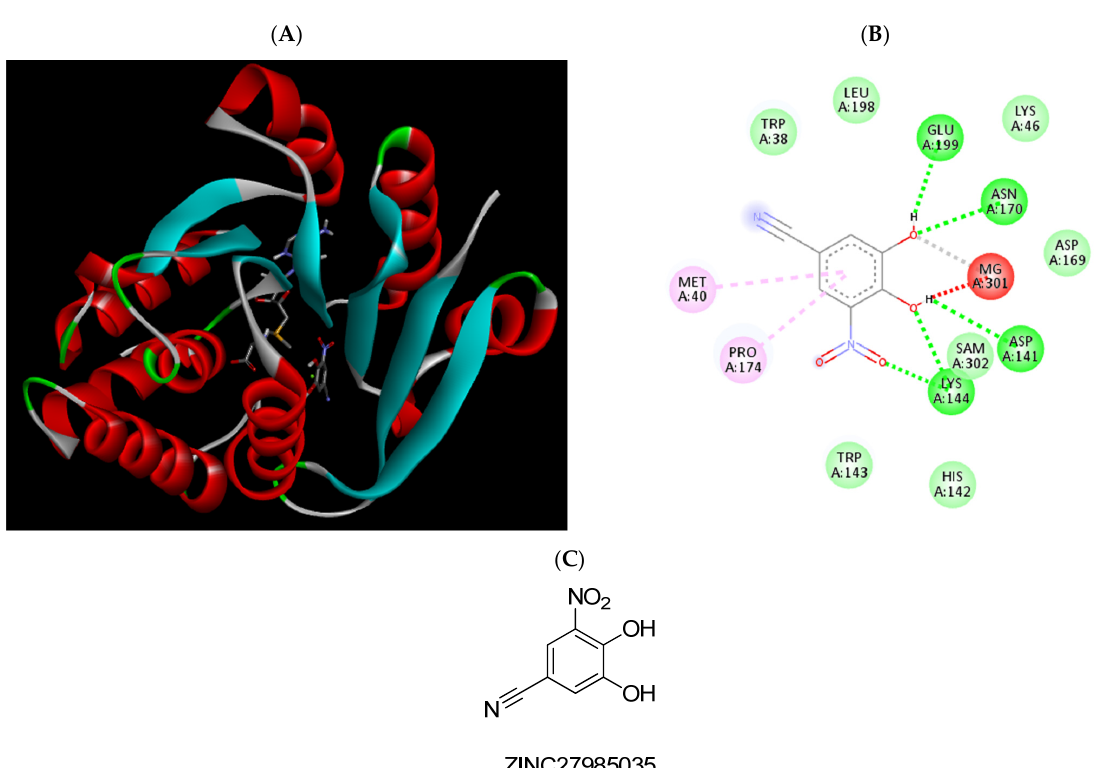
Figure 8. ( A ) Binding modes of ZINC27985035 with the crystal structure of human COMT complexed with SAM and Mg 2+ , ( B ) receptor–ligand interactions, ( C ) 2D representation of ZINC27985035.